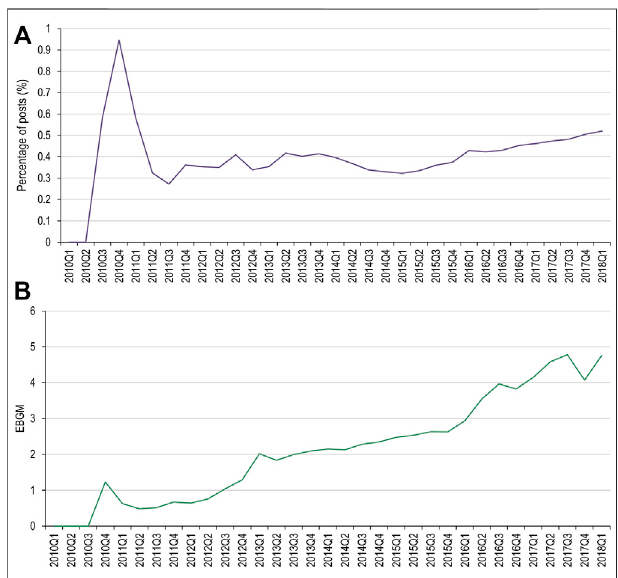
FIGURE 3 | Percentage of social media posts that mention denosumab and spinal fracture as an adverse event (A) and EBGM scores for denosumab and spinal fractures from FAERS data (B) . FAERS, Food and Drug Administration Adverse Event Reporting System; Q, quarter; EBGM, empirical Bayes geometric mean.